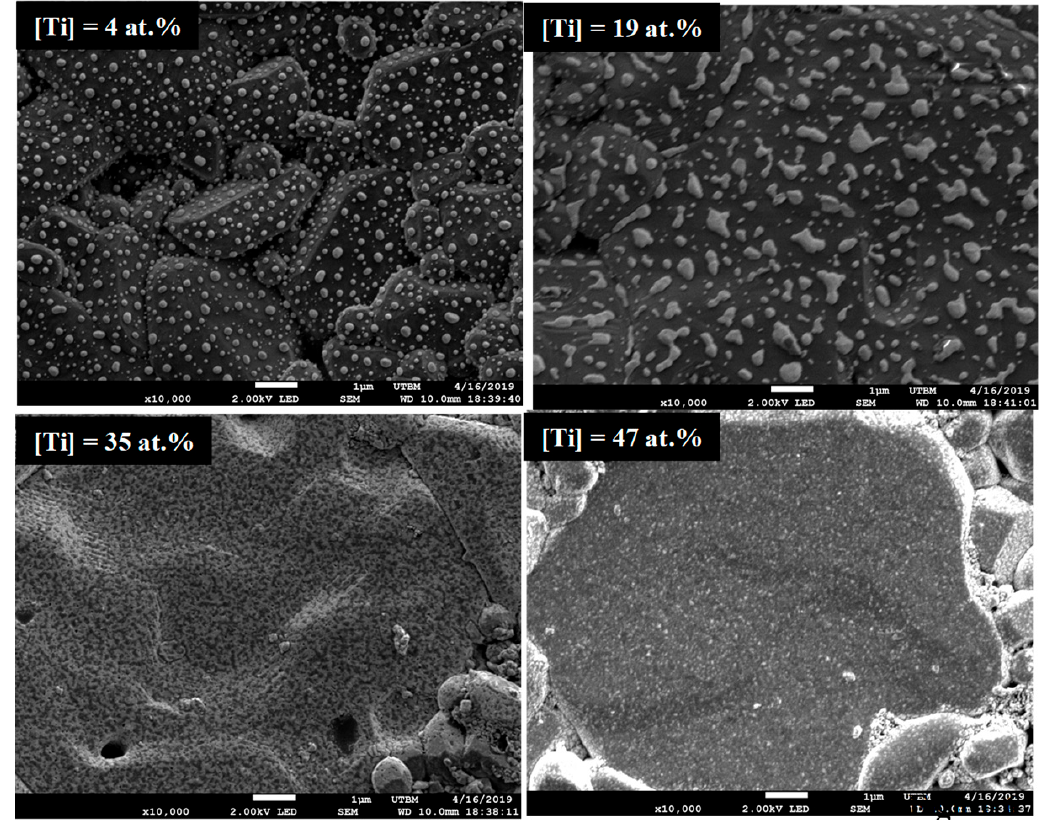
ff erent Pt–Ti films after resistivity